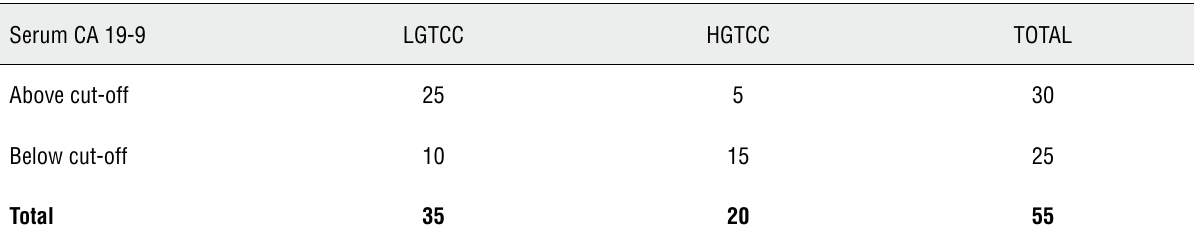
Table 4 - Comparison of serum level of CA19-9 between Low grade and High grade transitional cell carcinoma with a cut-off of value for serum CA-19-9 of 17.9